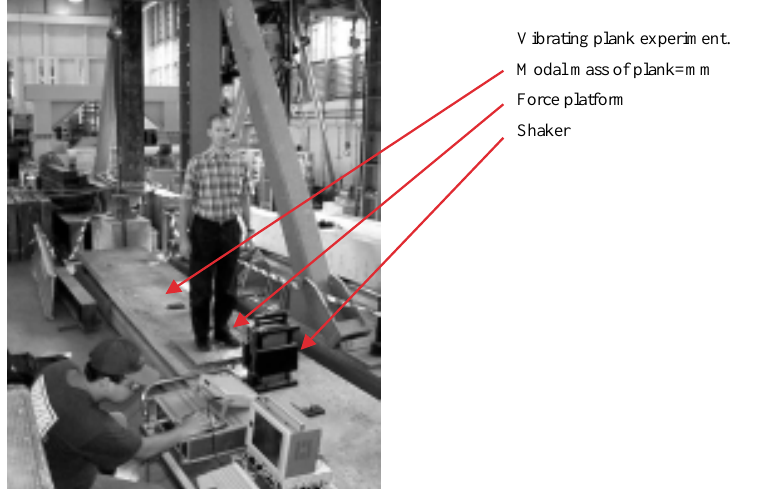
Fig. 1. Vibrating plank